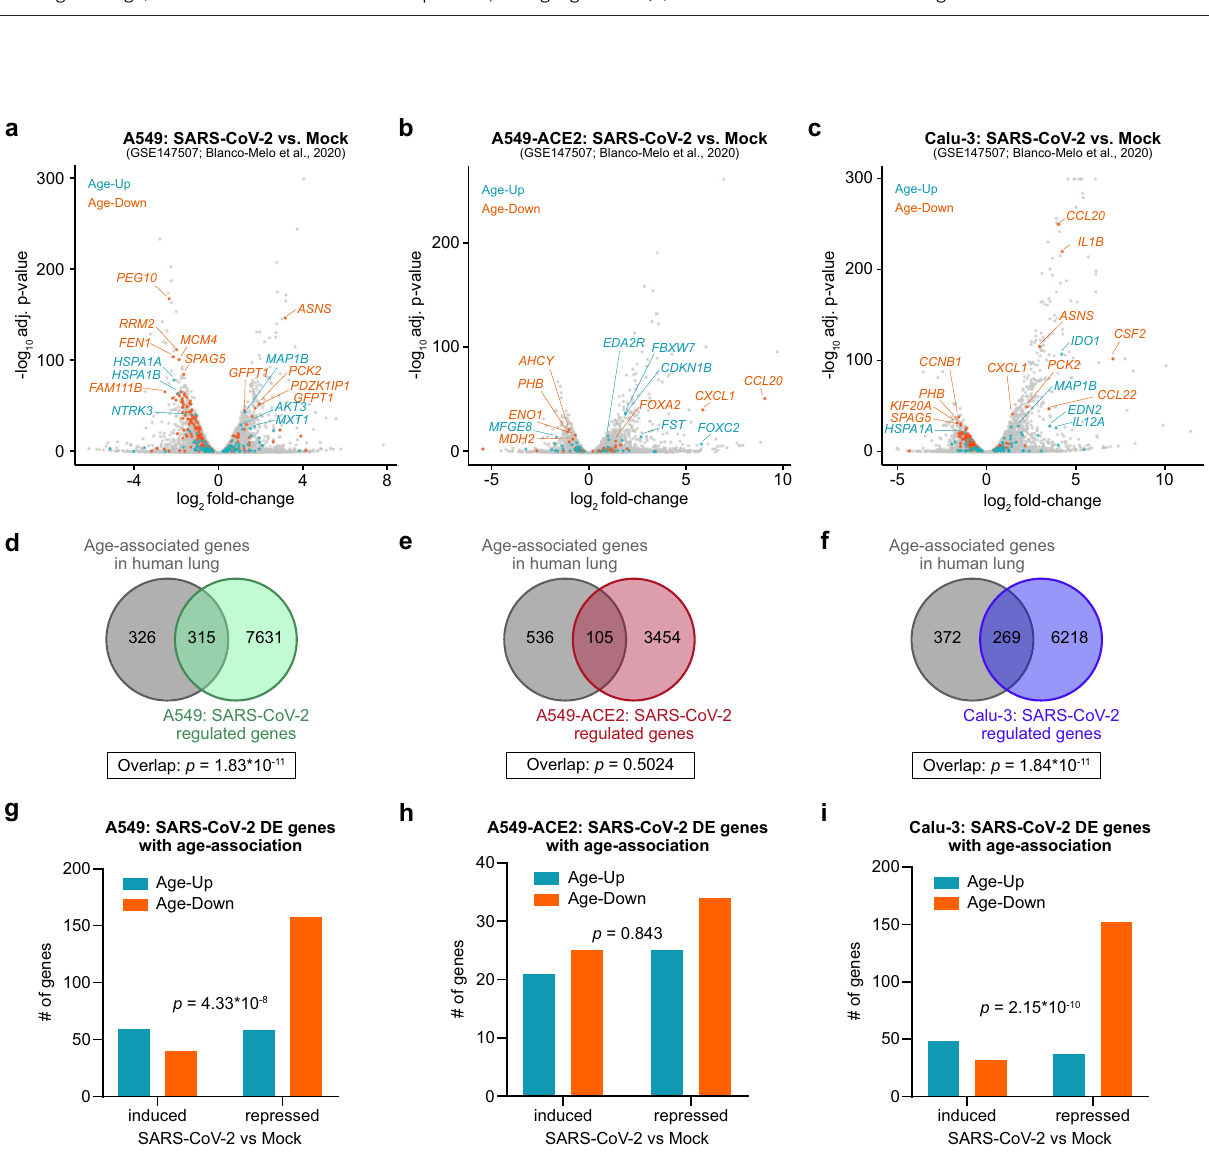
Fig. 4 Age-associated genes in the human lung interact with SARS-CoV-2 proteins. a Venn diagram of the intersection between age-associated genes in human lung and the SARS-CoV-2: human protein interactome 73 . Of the 14 age-associated genes that were found to also interact with SARS-CoV-2, 7 of them increased in expression with age, while 7 decreased with age. b Age-associated genes in human lung and their interaction with SARS-CoV-2 proteins, where each block contains a SARS-CoV-2 protein (underlined) and its interacting age-associated factors. Blocks are colored by the dominant directionality of the age association (orange, decreasing with age; blue, increasing with age). Gene targets with already approved drugs, investigational new drugs, or preclinical molecules are additionally denoted with an asterisk. c Tukey boxplots (interquartile range (IQR) boxes with 1.5× IQR whiskers) detailing the expression of select age-associated genes that interact with SARS-CoV-2 proteins, highlighted in ( b ) ( n = 561 samples). Data are shown as log- transformed expression values, adjusted for sex, smoking status, and Hardy scale. The SARS-CoV-2-interacting protein is annotated in parentheses. Statistical signi fi cance of the expression variation across all age groups was assessed by a two-sided Kruskal – Wallis test on the adjusted expression values. d Heatmap showing the percentage of cells expressing each of the Age-Up genes (increasing with age) that interact with SARS-CoV-2 proteins, as highlighted in ( b ). Data are from the Human Lung Cell Atlas 44 . e Heatmap showing the percentage of cells expressing each of the Age-Down genes (decreasing with age) that interact with SARS-CoV-2 proteins, as highlighted in ( b ). Data are from the Human Lung Cell Atlas 44 .